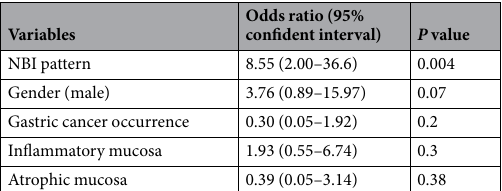
Table 2. Multivariate analysis assessing the factors related to methylation-high cases. * Methylation high, mean Z score of methylation > 0.15. * Mean Z score of methylation more than 0.15 was considered methylation